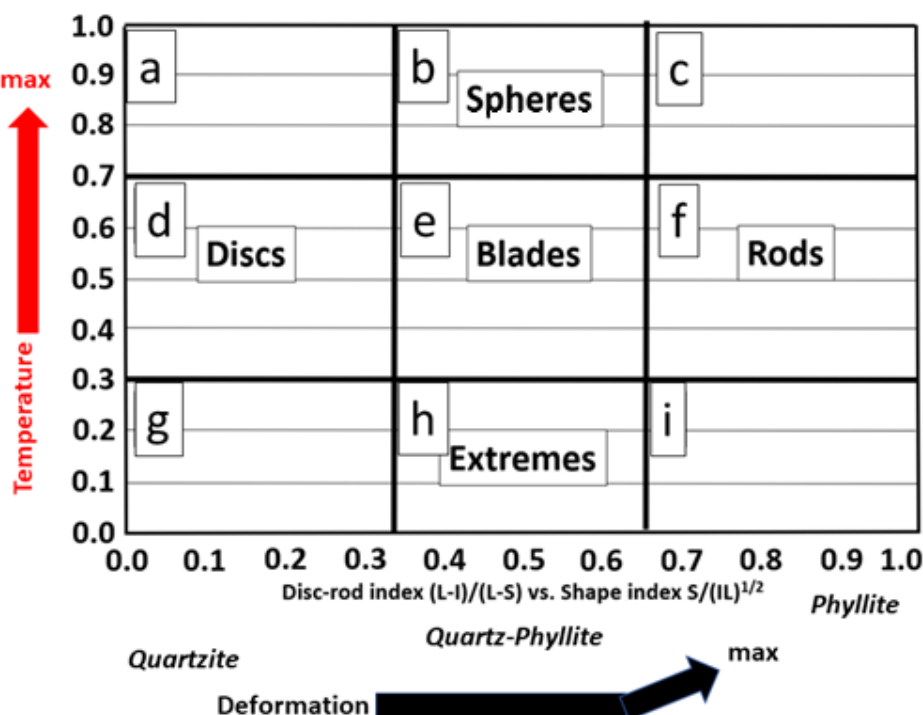
Figure 6. Denomination of grain morphology modified from Illenberger [24] in an x-y plot. X = disc-rod index, y = shape index. L = long, I = intermediate, and S = short, represent the three axes of a clast. Red arrows are representative of the temperature influence on lithoclast morphology, black arrows are representative of the influence of deformation on the meta-psammopelitic lithoclasts. ( a ) unnamed transition zone; ( b ) spheres; ( c ) unnamed transition zone; ( d ) discs; ( e ) blades; ( f ) rods; ( g ) unnamed transition zone; ( h ) extremes; ( i ) unnamed transition